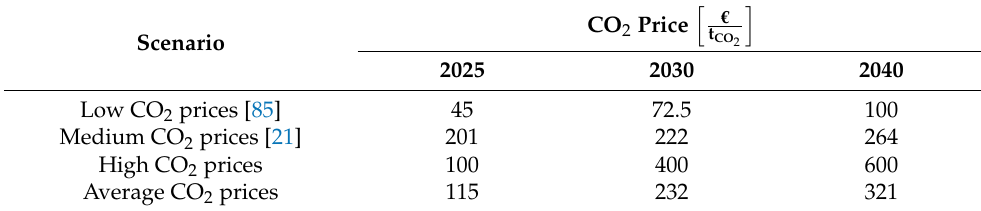
Table 3. CO 2 price pathway assumptions.